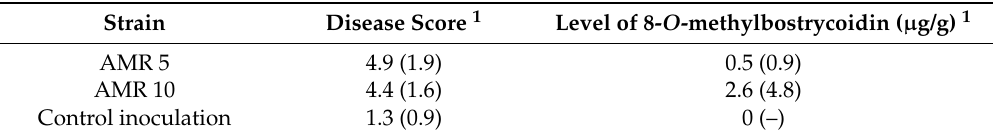
Table 1. Results for field evaluation of disease level and 8- O -methylbostrycoidin production in maize ears upon inoculation with F. verticillioides